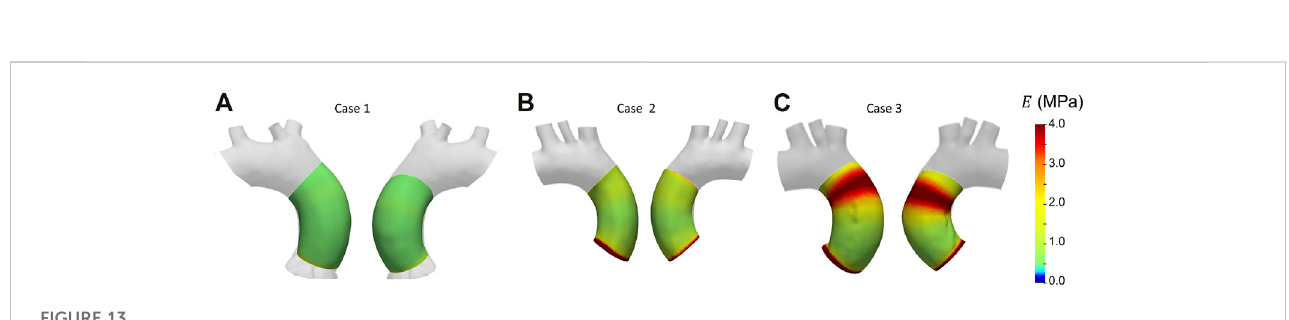
Frontiers in Bioengineering and